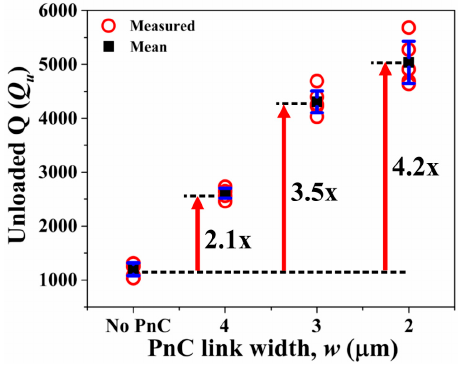
Figure 9. Fully covered resonators with seven IDT fingers transduced in the 7th-order symmetric Lamb mode—Extracted values of unloaded Q ( Q u ) of the control design with no PnCs in comparison to the three other devices with PnCs in the anchors with different inter-cell link widths. The black squares denote the mean value while the error bars denote the standard deviation over five samples.